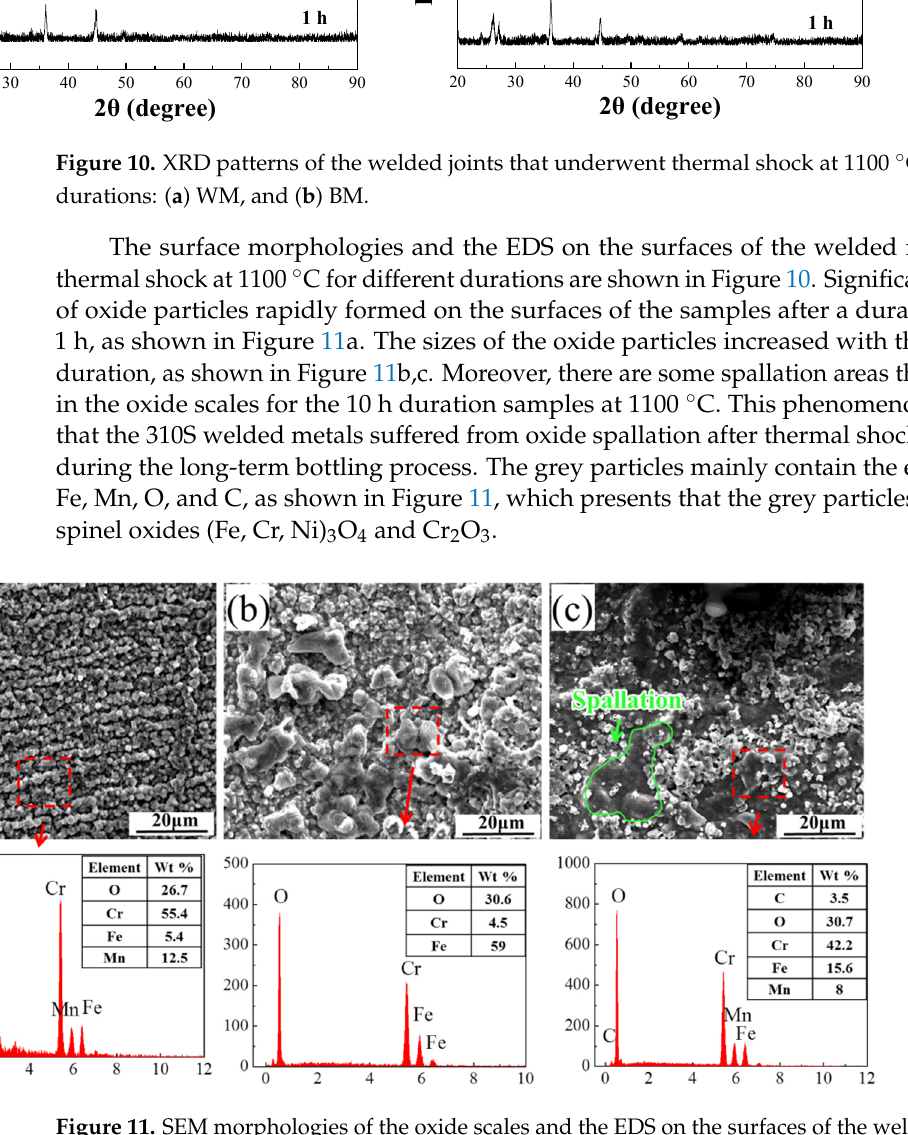
Figure 11. SEM morphologies of the oxide scales and the EDS on the surfaces of the welded metals at different durations: ( a ) 1 h, ( b ) 6 h, and ( c ) 10 h.